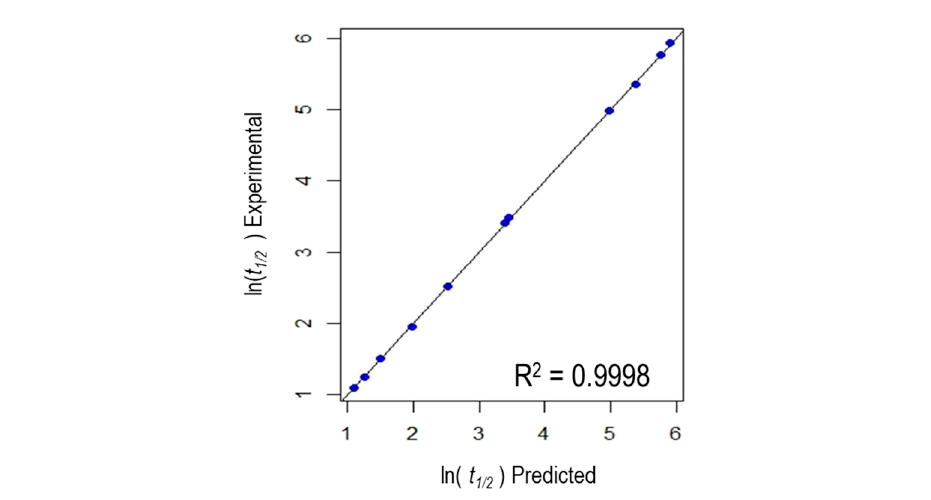
Figure 6. Comparative plot between experimental and predicted values.